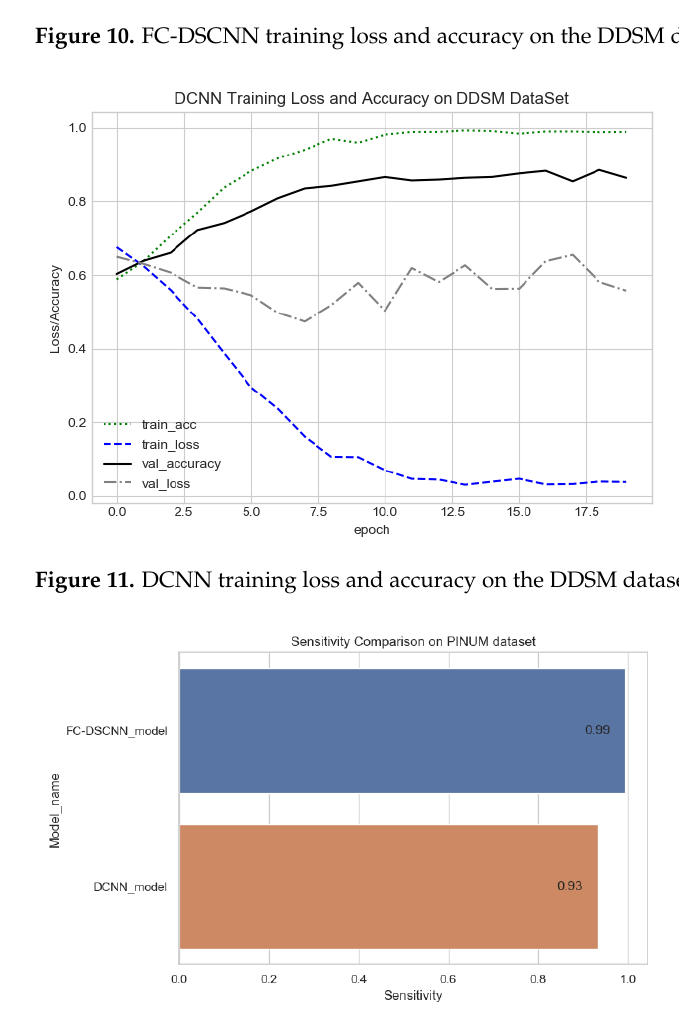
Figure 12. Sensitivity comparison on the PINUM